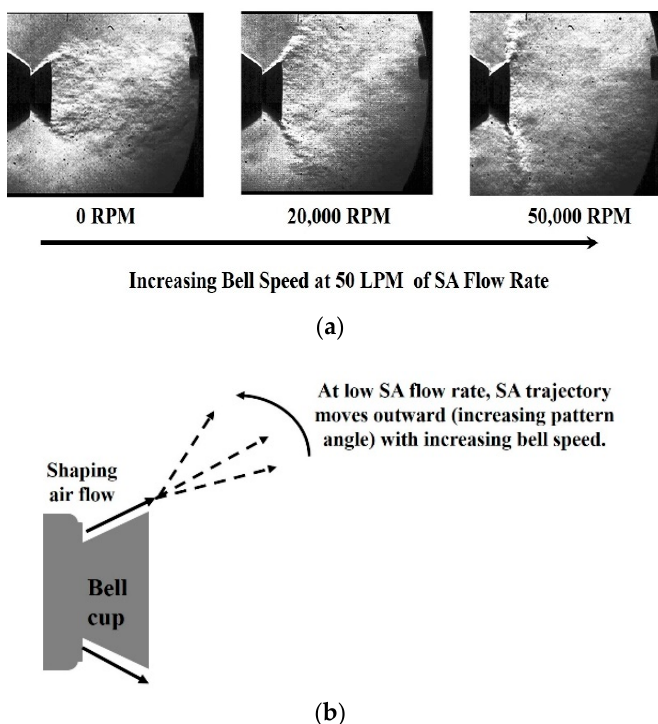
Figure 3. ( a ) Schlieren images of SA flow away and outward from the edge of the ERBS bell cup; increased cup rotational speeds at a fixed SA flow rate increased the radial dimension over which SA flowed. ( b ) A schematic illustrating the SA flow dynamics with increasing bell cup rotational speeds.